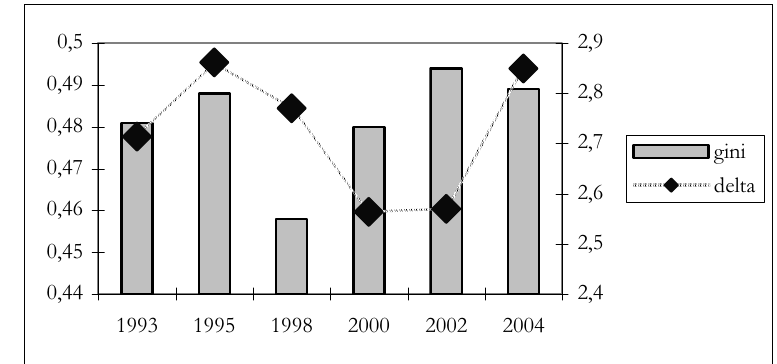
Figure 5 – Dagum model for human capital in Italy from 1993 to 2004, Gini index and 1 parameter.